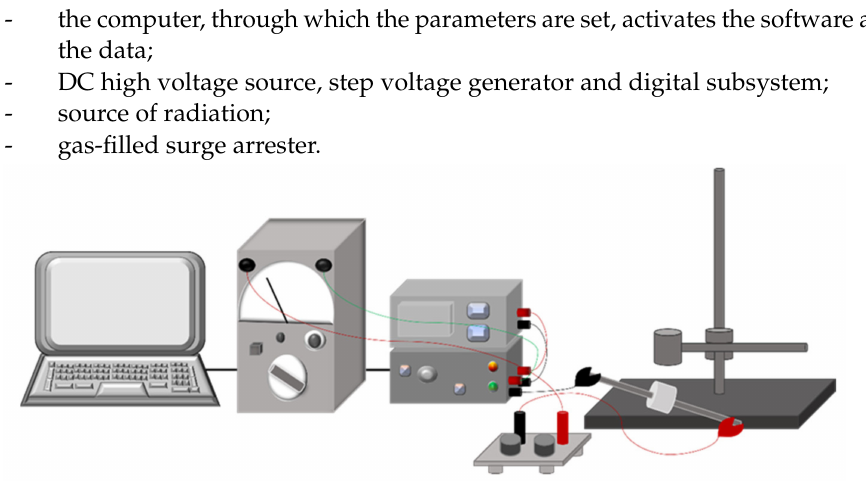
Figure 2. Graphical illustration of computer-controlled equipment of breakdown voltage measure- ment and data acquisition.